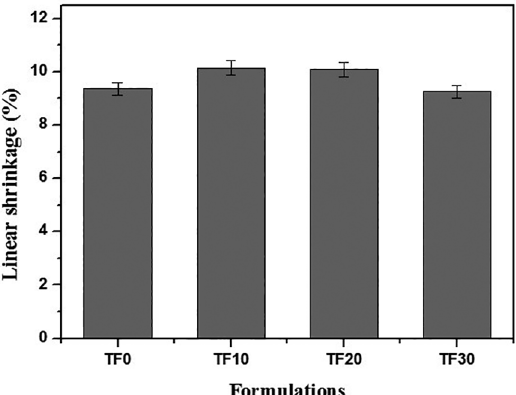
Figure 4. Linear shrinkage of the fired aluminous porcelain pieces.